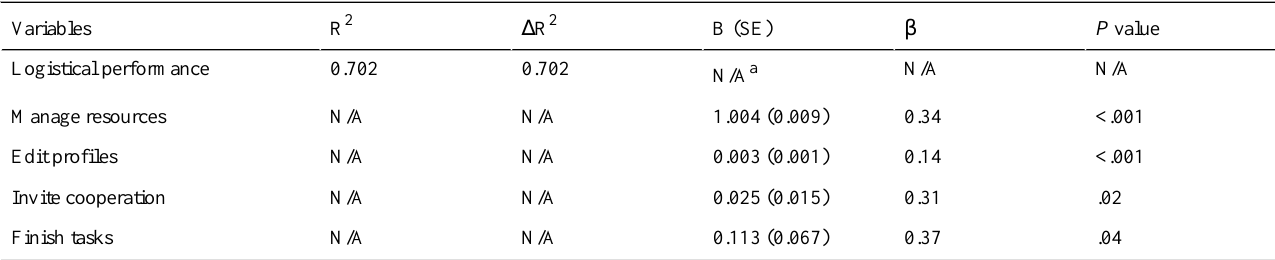
Table 4. Regression analyses predicting logistical performance based on attributes of learning engagement in the multiplayer online serious game case